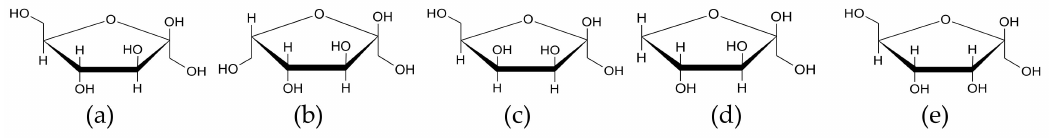
Figure 5. Furanose forms of ( a ) D-fructose, ( b ) L-sorbose, ( c ) D-tagatose, ( d ) D-xylulose, and ( e )